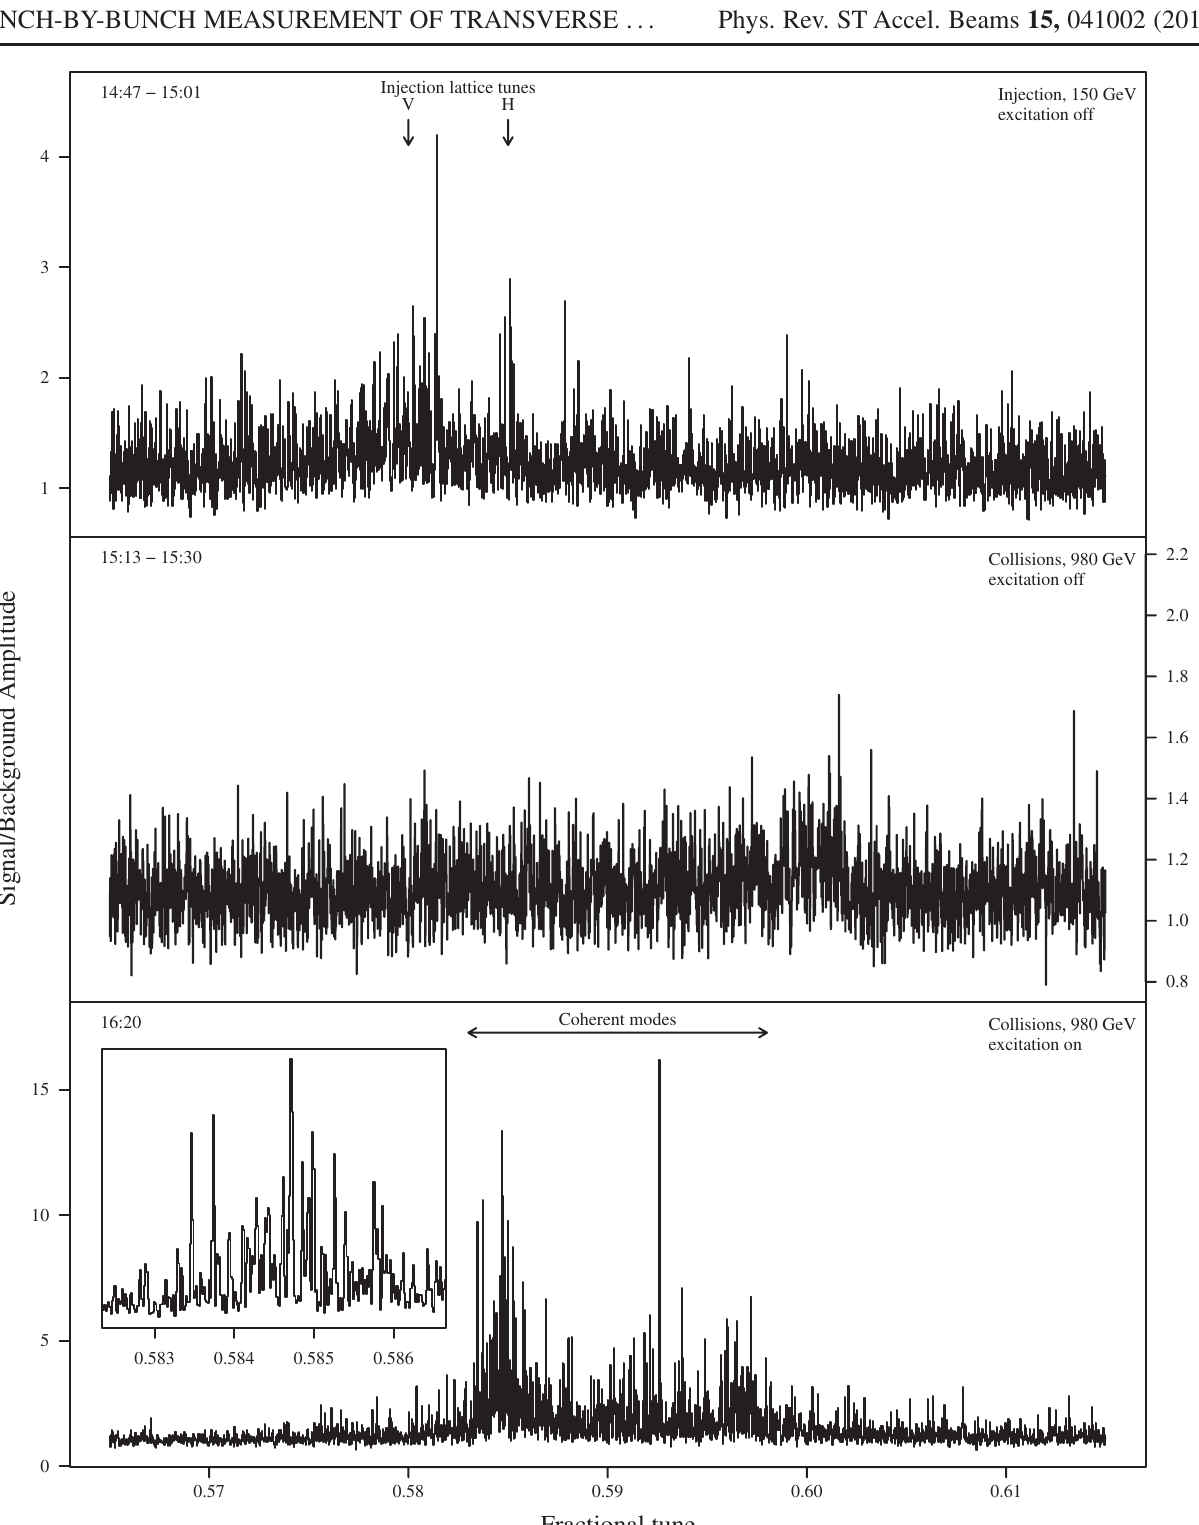
FIG. 7. Vertical coherent modes for one proton bunch during Store 7706, at injection and at